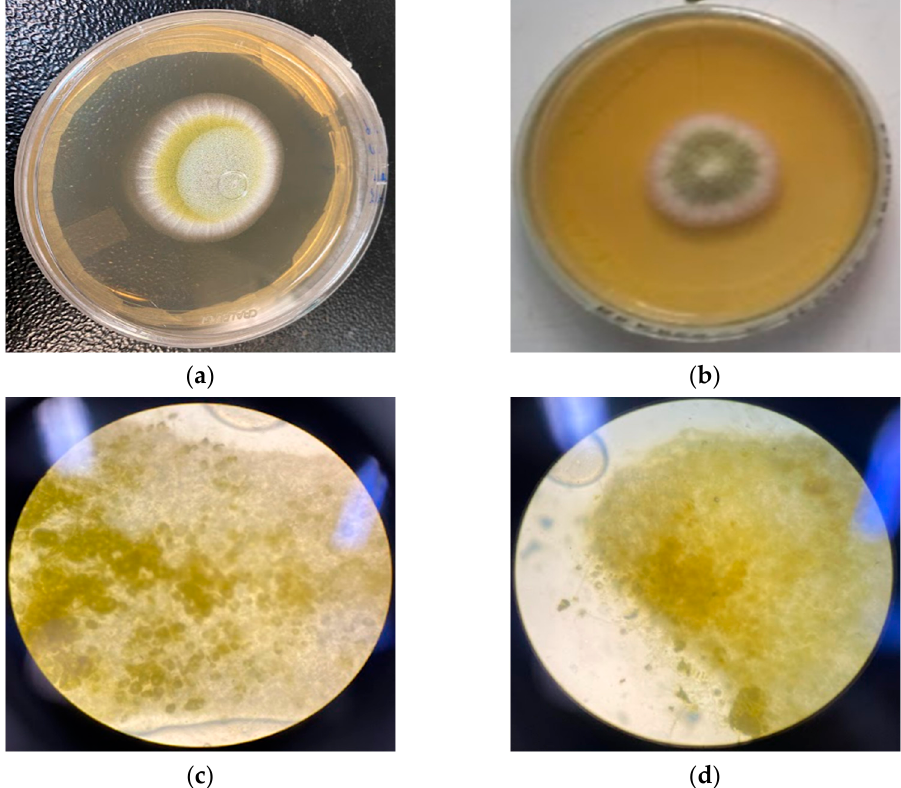
Figure 4. Macroscopic and microscopic comparison between the control colony and the colony with the NE at 2048 µg/mL at 48 h: ( a ) A. fl avus colony, ( b ) A. fl avus colony in the presence of the NE the NE at 2048 µ g/mL at 48 h: ( a ) A. flavus colony, ( b ) A. flavus colony in the presence of the NE at at 2048 µg/mL, ( c ) microscopy of A. fl avus , and ( d ) microscopy of A. fl avus in the presence of the NE 2048 µ g/mL, ( c ) microscopy of A. flavus , and ( d ) microscopy of A. flavus in the presence of the NE at at 2048 µg/mL. 2048 µ g/mL.